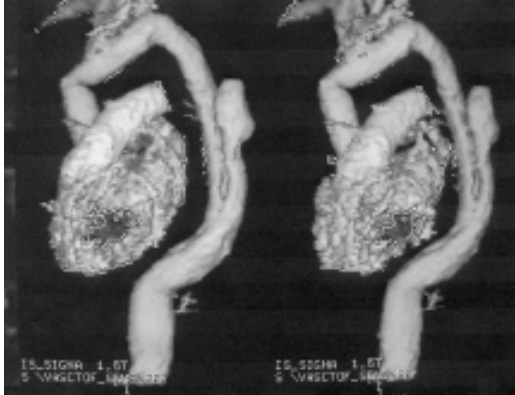
Fig. 4 - Post-operative study by magnetic angioresonance showing the tube substituting the ascending aorta and aortic arch and elephant trunk in the descending aorta.